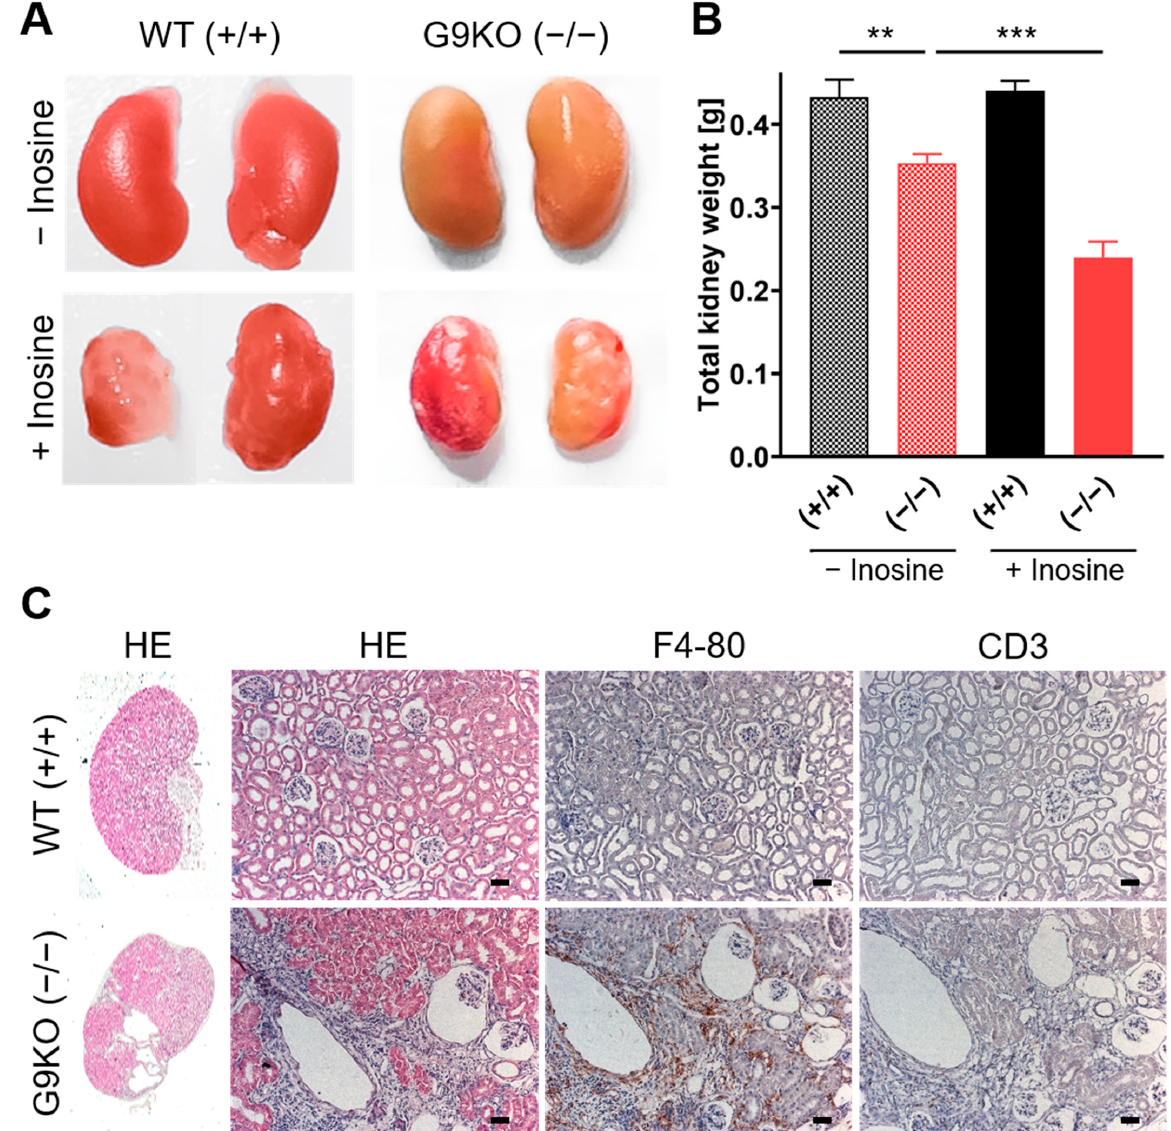
Figure 5. Male kidney status: ( A ) Kidneys isolated at day 70 after birth from WT and G9KO male mice under a control diet and inosine supplementation. The morphological changes observed in G9KO male animals are significantly higher than the morphological changes observed in female G9KO animals. ( B ) Inosine supplementation results in a higher reduction in kidney mass in KO compared to WT animals. ( C ) HE, F4/80 (macrophages), and CD3 (T cells) stainings of WT (+/+) and KO ( − / − ) animals exposed to inosine during fetal development. Scale bar: 25 μ m size; ** p < 0.01, *** p < 0.001.